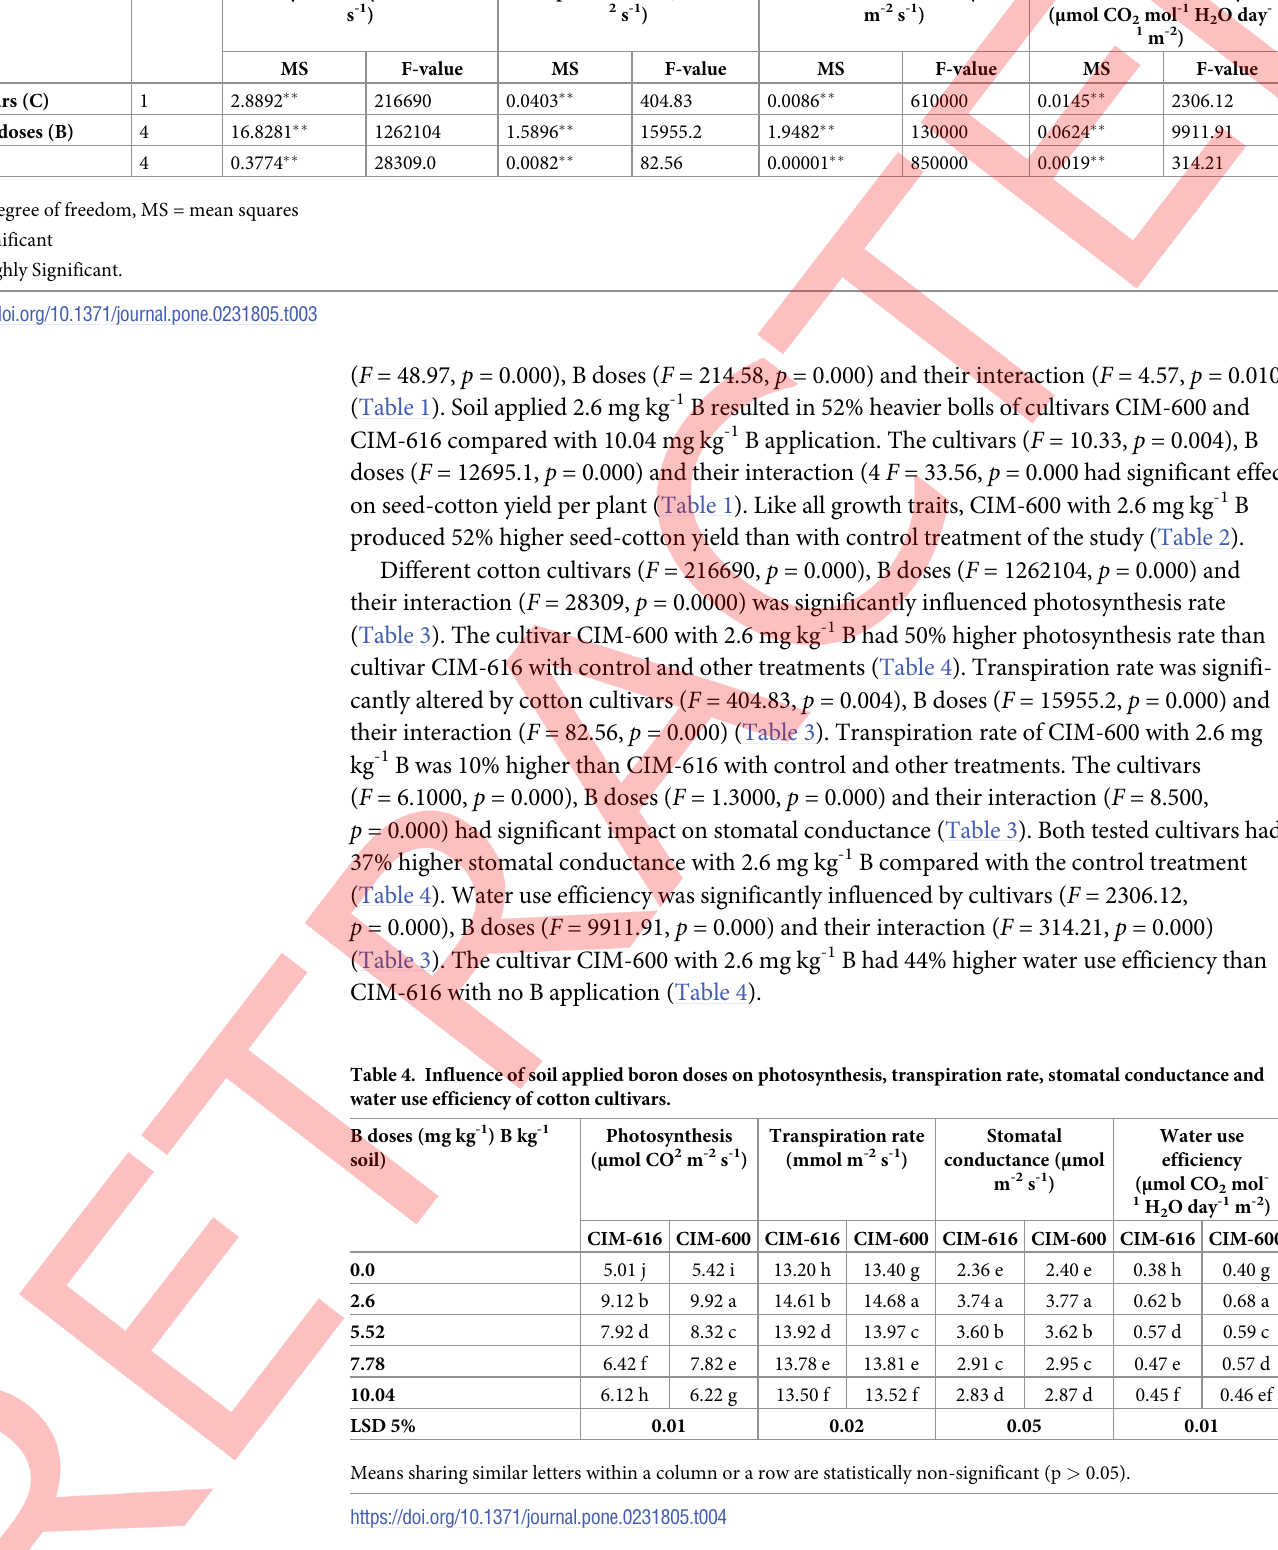
Means sharing similar letters within a column or a row are statistically non-significant (p >